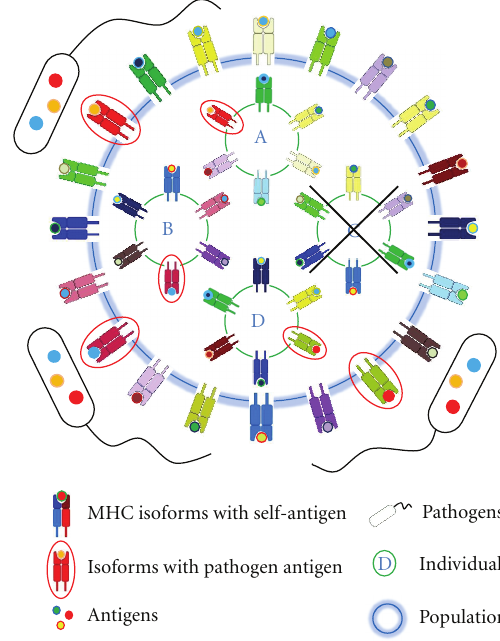
Figure 3: Protective e ff ect of MHC polymorphism on populations (simplified scheme). Evolution of MHC genes and alleles is driven by the need to maximize peptide binding diversity in order to recognize a maximum of potential pathogens. Thus, the extreme polymorphism of MHC molecules of vertebrates is thought to reflect a pathogen-driven selection. This insures that no germ can exterminate the whole population by developing peptides that cannot be bound by any MHC molecule. However, compared to the enormous diversity of MHC molecules within a population (outer circle), their heterogeneity within a single individual is restricted to a few di ff erent MHC polypeptides (individuals A–D). This can be attributed to a mechanism called “MHC restriction” (see MHC chapter) that limits polygeny of the MHC genes (in general to 3 genes per MHC class I and class II). As a consequence some agents may evolve polypeptides that evade the immune system of single individuals (individual C) and harm or even kill them. In consequence of these opposed requirements, the immune surveillance is a delicate balance between (self-)tolerance and immune response that ensures survival of a population and/or a species at the expense of single